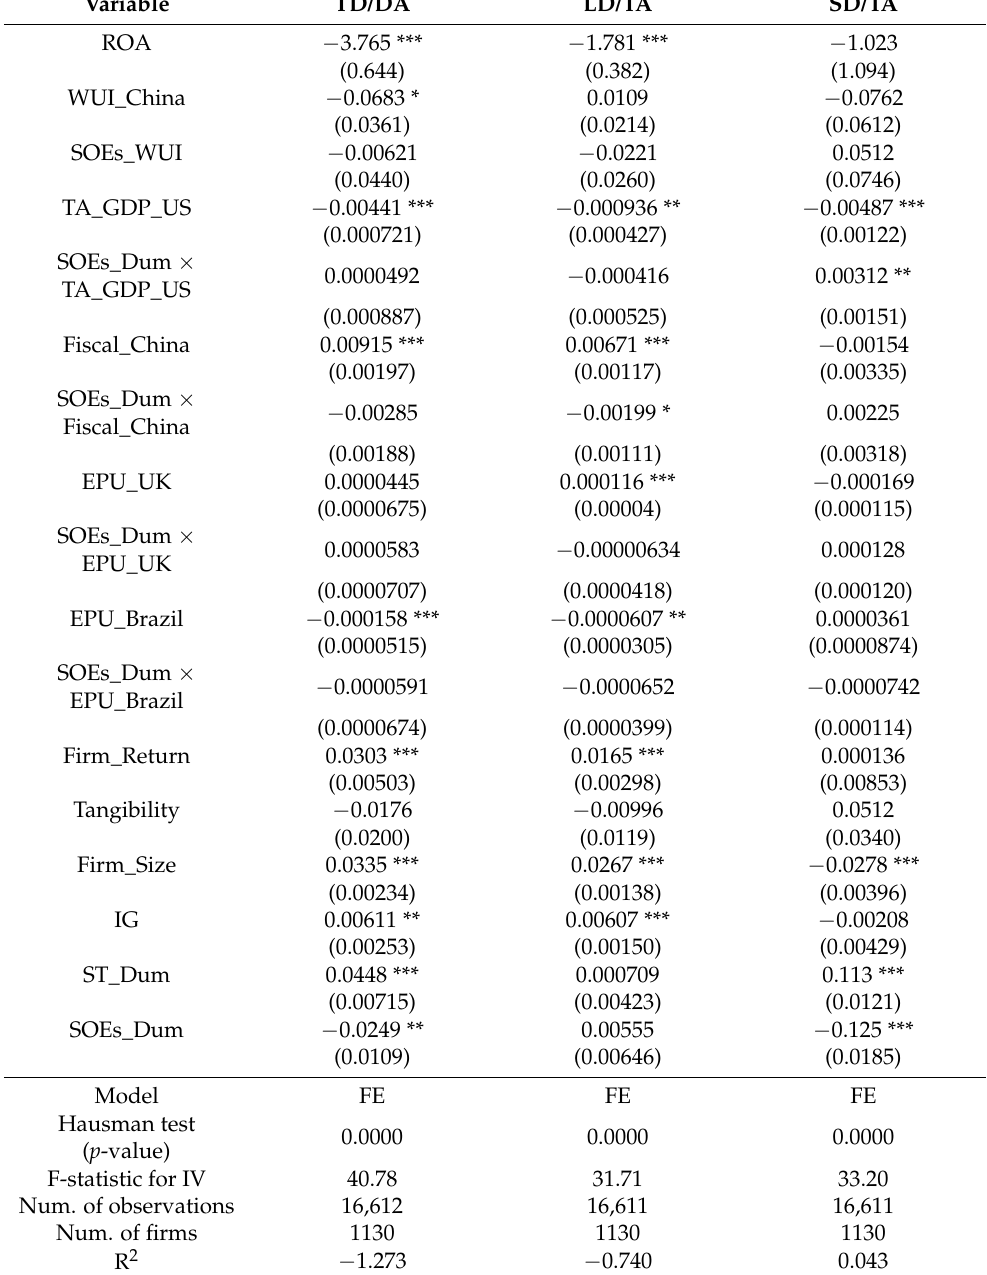
Table 7. The impacts of the economic uncertainty on capital structure by state ownership: robustness